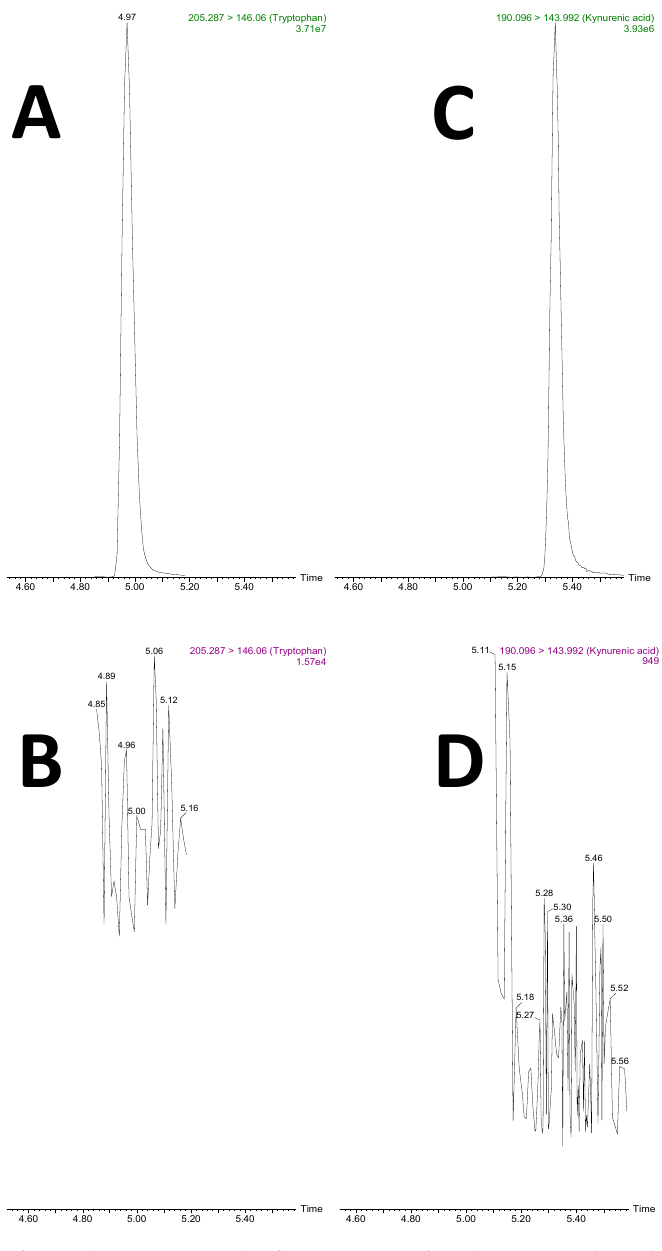
Figure 3. MRM of TRP (205.29 > 146.06) after injection of a plasma sample spiked at the highest concentration (panel A ) and injection of ACN at the end of the entire batch ( n = 5) ( B ). MRM of KA (190.09 > 143.99) at the highest point of calibration ( C ) and in the following run after injection of ACN ( D ) .